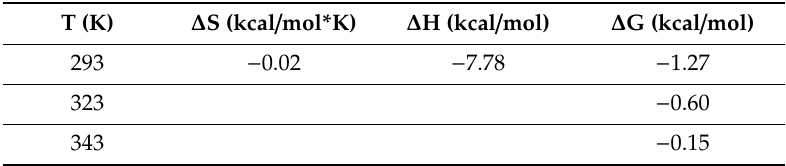
Table 1. Thermodynamic parameters derived from the temperature dependence of the glutaraldehyde solution NMR spectra.